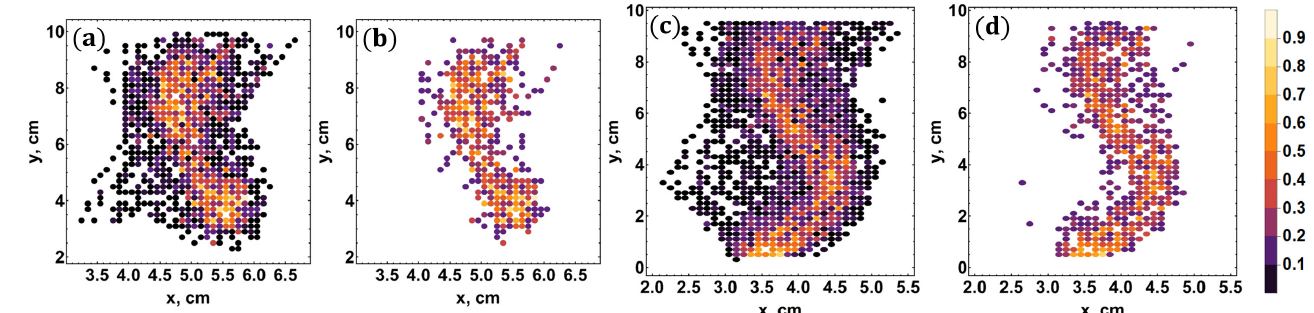
Figure 15. Normalized bubble detection density histograms with ( dx , dy ) = ( 2,4 ) mm bins color-coded by detection counts: ( a , b ) the case in Figure 14a with ( a ) all bins and ( b ) bins with 3+ detections shown; ( c , d ) the case in Figure 14b with ( c ) all bins and ( d ) bins with 4+ detections shown. Note the color legend to the right of ( d ).